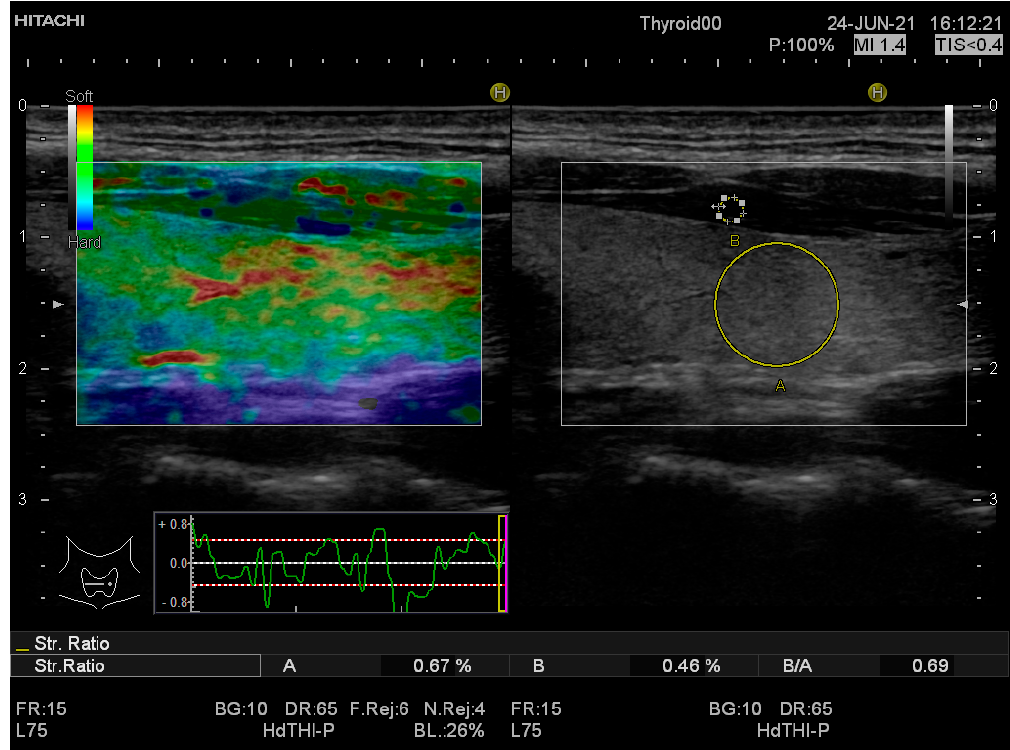
Figure 2. Strain elastography ( left ) and grey-scale ultrasound (US) ( right ) of a girl, age 16 with no thyroid pathology. The yellow circle A is the local region of interest (ROI) on the thyroid tissue; the yellow circle B is the local ROI on the sternocleidomastoid muscle adjacent to the thyroid. Strain ratio (SR) =